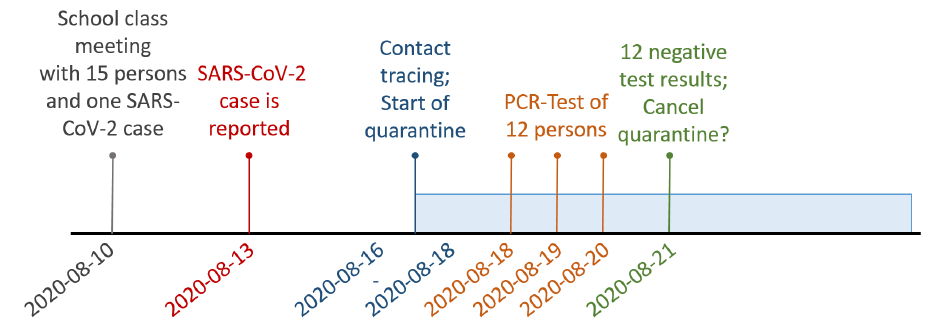
Figure 4. Timeline of the school class example. Table 2. A dataset of a school class from the health department in Berlin-Reinickendorf, which contains the last contact date, the PCR test date, and the PCR results. Case Number Date of Last